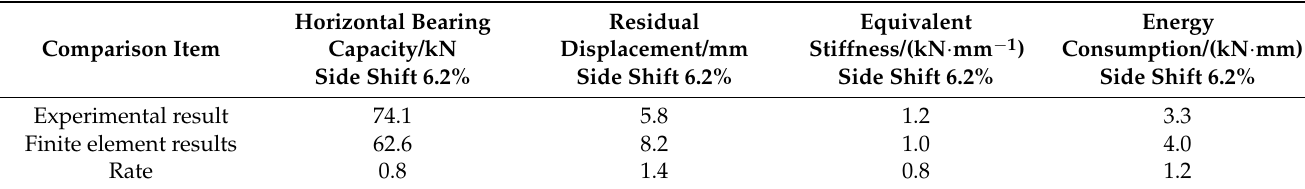
Table 3. Comparison between test values and simulation values.